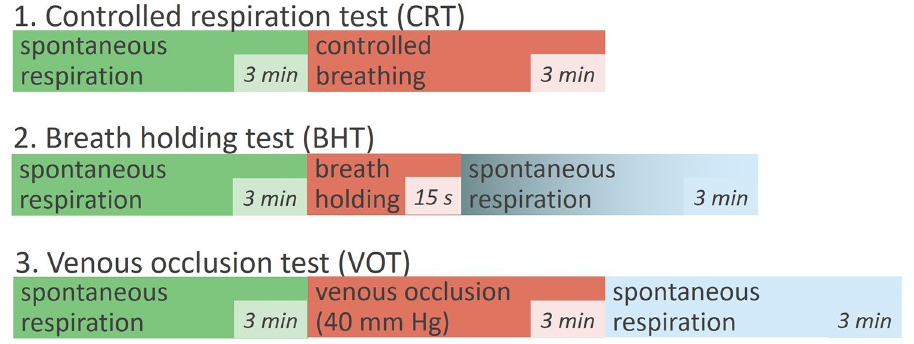
Fig 2. Scheme of three experimental protocols: Controlled respiration test (CRT), breath holding test (BHT), venous occlusion test (VOT).